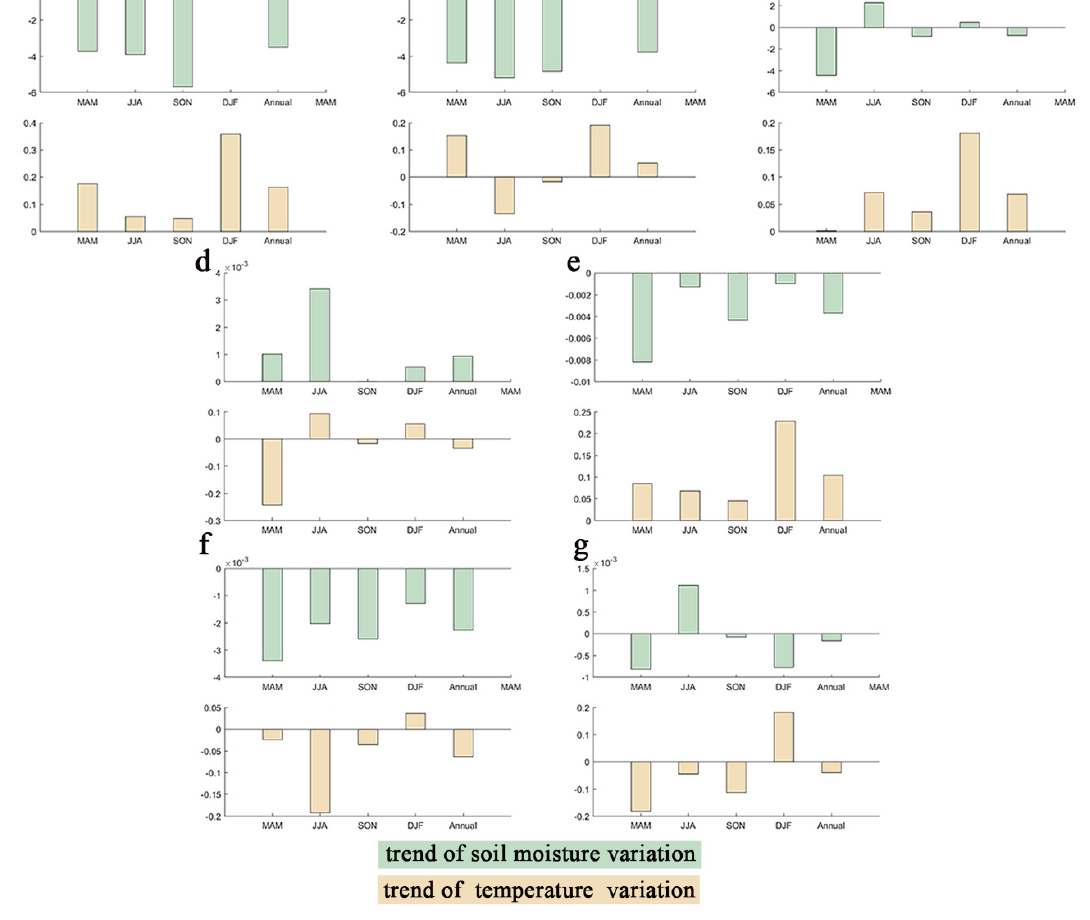
Figure 7. Seasonal and annual tendencies of soil moisture and air temperature in 7 regions of China.